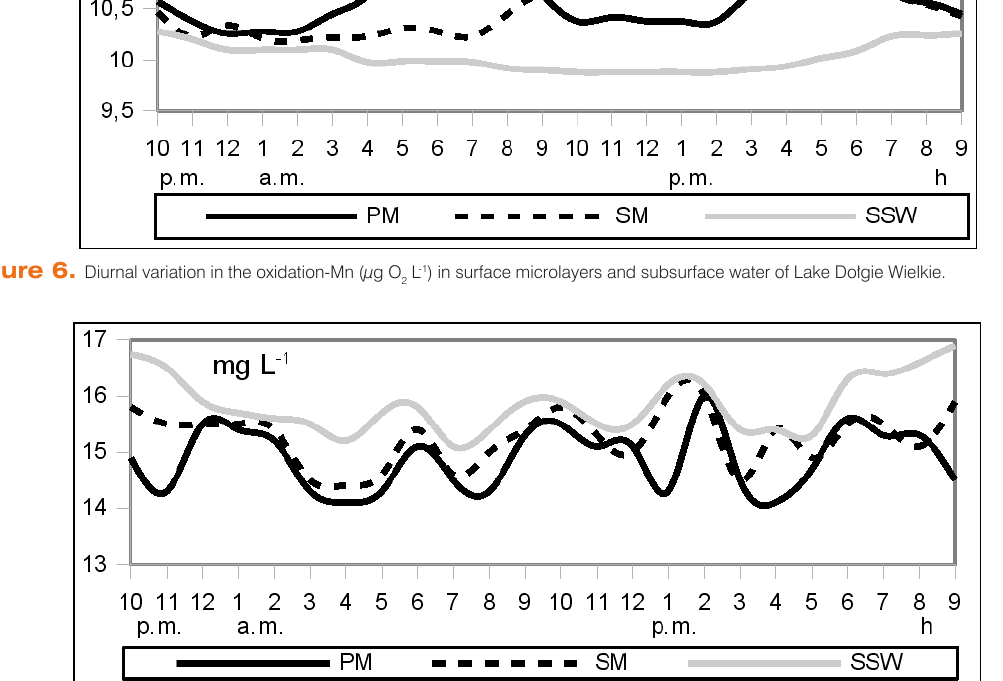
Figure 7. Diurnal variation in the concentration of chloride ions (mg L -1 ) in surface microlayers and subsurface water of Lake Dołgie